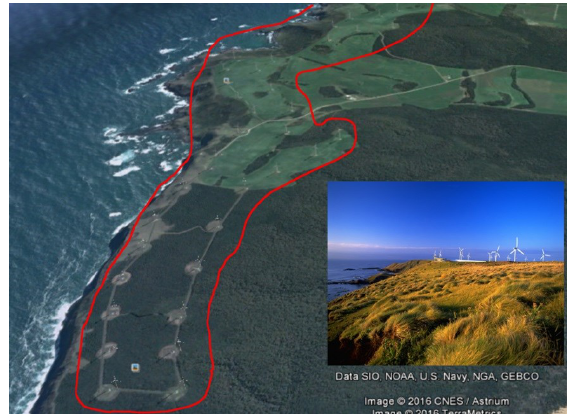
Figure 1. A satellite image of the Woolnorth wind farm sourced from Google Earth (Data SIO NOAA US Navy, NGA, GEBCO, Image CNES/Astrium) [24]. The farm itself is enclosed by the red line. The inset is a photo of the wind farm taken from ground level at the southern end of the wind farm to better indicate the topography and vegetation of the cliff-top location [22].